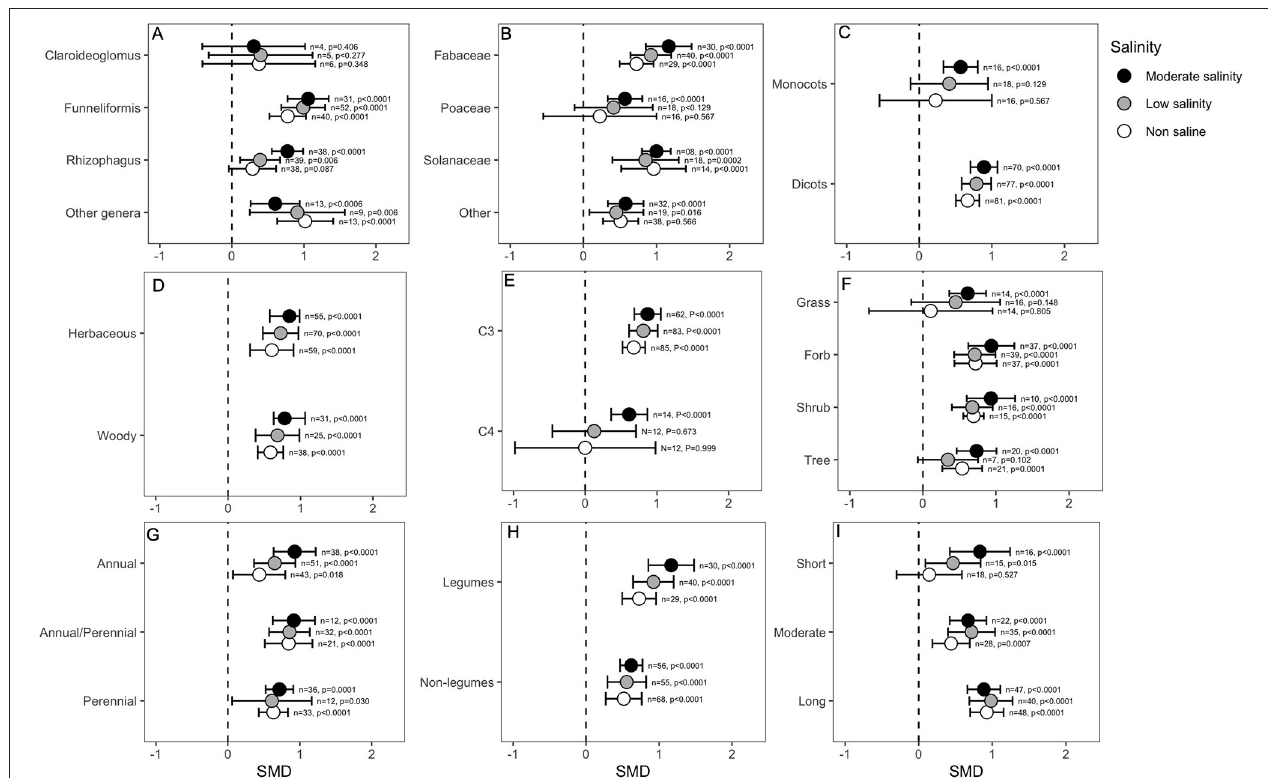
FIGURE 5 | Effect of mycorrhizae on plant root dry biomass under non-saline, low salinity, and moderate salinity conditions for various categorical variables such as (A) Fungal genera, (B) Plant Family, (C) Plant clade, (D) Plant lifestyle, (E) Plant Photosynthetic pathway, (F) Plant Life forms, (G) Plant lifecycle, (H) Plant nodulation, and (I) Salinity duration. Error bars are effect size means 95% CIs. Where the CIs do not overlap the vertical dashed lines, the effect size for a parameter is ± significant, i.e., the growth responses of AMF plants were significantly different from those of non-AMF plants. n , number of studies included in the meta-analysis; p , significance level of